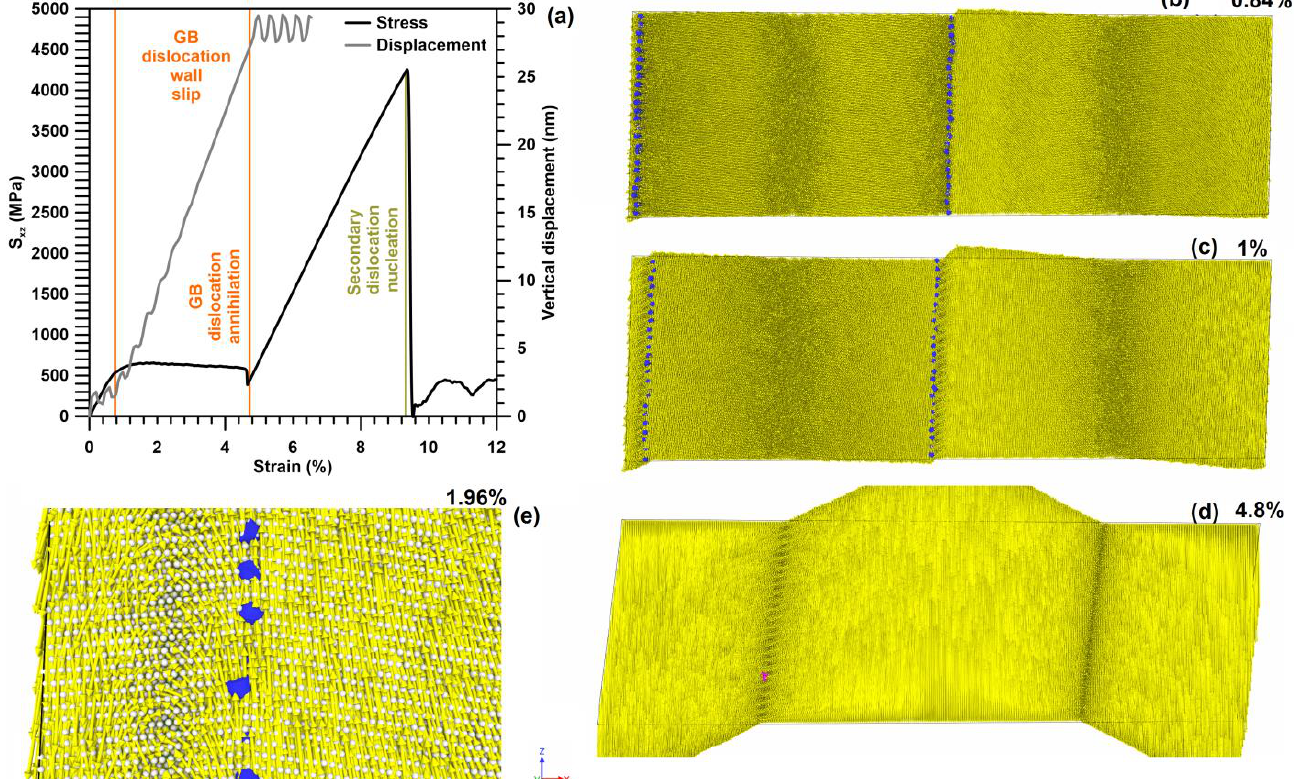
Figure 4. ( a ) Stress–strain dependence and dependence of vertical displacement in the system on strain. ( b , c ) Displacement vectors of atoms (yellow) and dislocation walls (blue dots). Dislocation walls slip to each other. The movement of dislocation walls leads to rearrangement of the atomic structure, causing a change in the position of atoms along z -axis. ( d ) Annihilation of the dislocation wall. A single stair rod segment (purple dot) is visible at the annihilation place. ( e ) Continuous distribution of displacement vectors forming vortex structures behind the left GB slipping to the right.